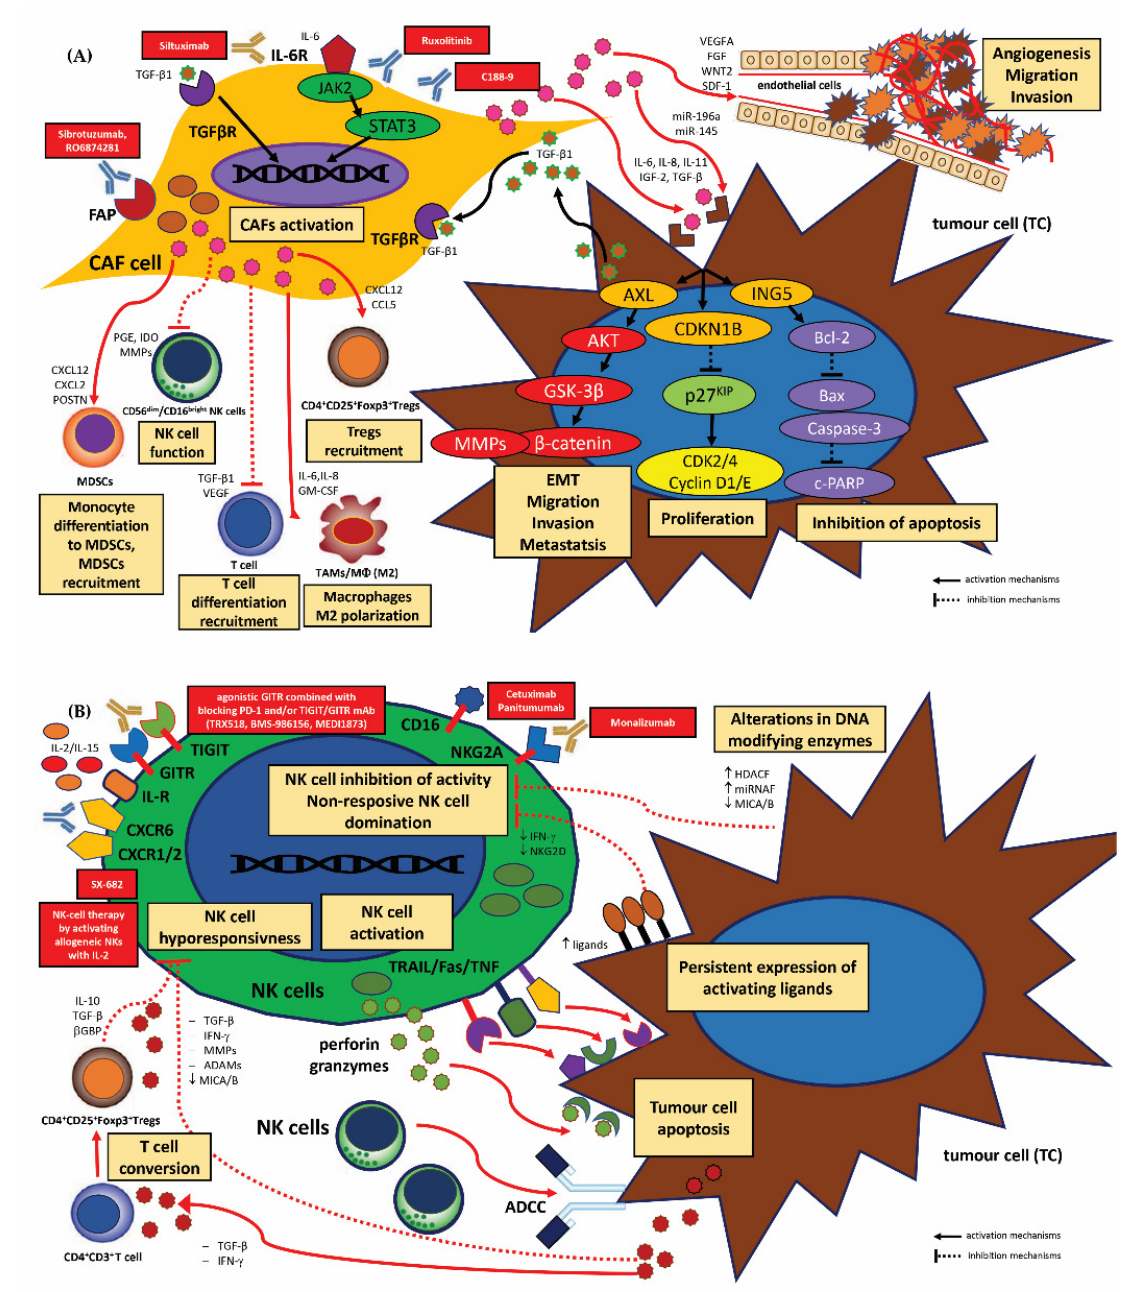
Figure 4. The functional effects of CAFs and NK cell activity and therapeutic strategies for targeting CAFs in HNSCC. ( A ) CAF-derived cytokines (TGF- β 1, IL-6, IL-8, IL-11, IGF-2) and microRNAs (miR-196a, miR-145) are transported via exosomes to HNSCC cancer cells. This results in the activation of AXL, CDKN1B and Bcl-2 and their downstream signalling. These pathways lead to increased β -catenin and MMP expression, as well as upregulation of cyclin D1/E and downregulation of c-PARP molecule. The effects are enhanced proliferation, migration, invasion and tumour cell metastasis, and inhibition of apoptosis. Secretion of cytokines, growth factors and other molecules (IL-6, IL-8, GM-CSF, TGF- β 1, VEGF, PGE, IDO, MMPs) by CAFs target various immune cells, inhibiting T cell and NK cell activity and enhancing CD4 + CD25 + Foxp3 + T regs , MDSC and M2 TAM recruitment and function, ( B ) NK cell recognition is mediated by a balance of activating and inhibitory signals. NK cells kill target tumour cells by the release of cytotoxic granules containing perforin and granzymes, by the expression or release of TRAIL, TNF and FasL and by antibody-dependent cellular cytotoxicity (ADCC), resulting in apoptosis of the target cell. Tumour cells may escape NK cell dependent immunosurveillance by alterations in DNA modifying enzymes, such as those involved in